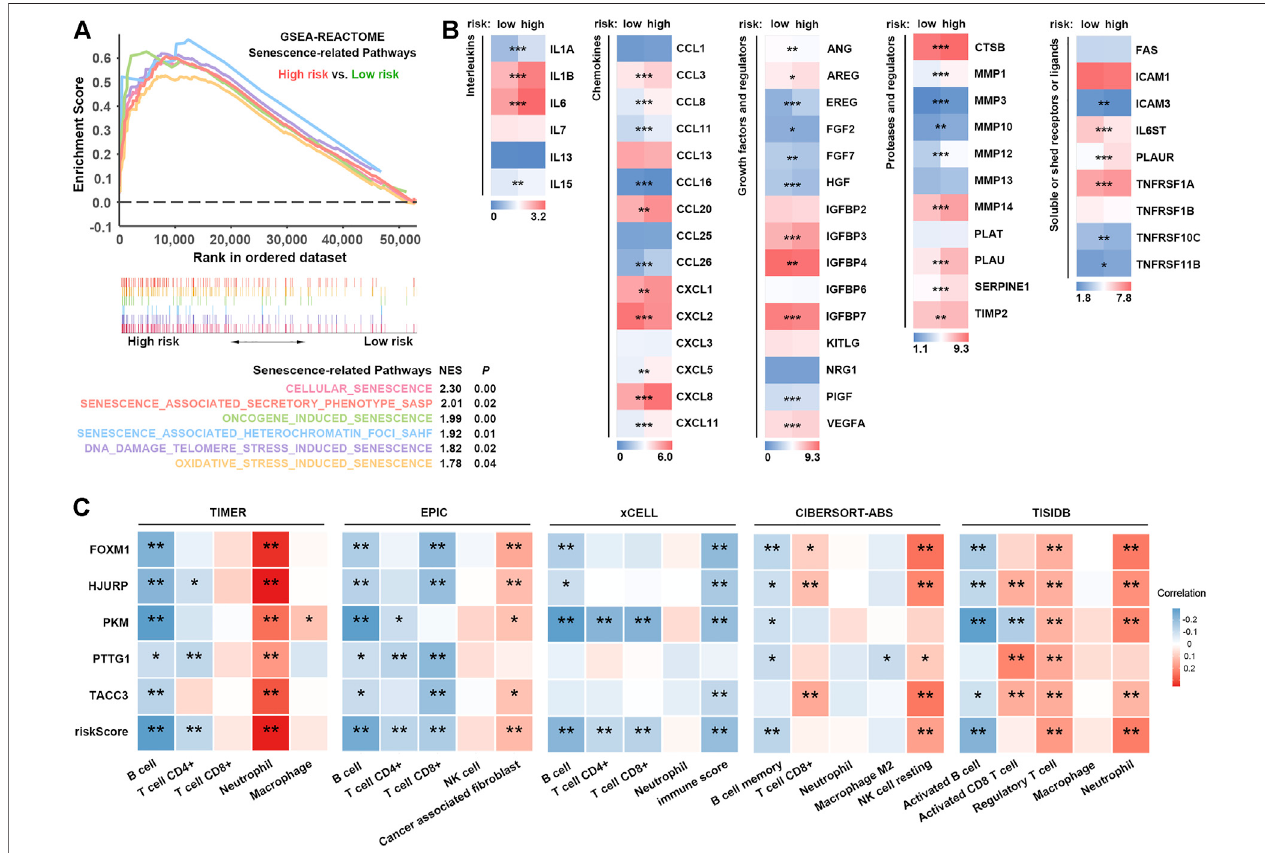
FIGURE 5 | SRS-related SASP and immune cell in fi ltration. (A) . Comparison of signatures related to multiple pathways of cellular senescence between high- and low-risk groups. (B) . Expression of different types of SASP factors between high- and low-risk groups. (C) . Correlation analysis between risk scores and different immune cells estimated by TIMER, EPIC, xCELL, CIBERSORT-ABS and TISIDB. *, **, and *** represent P < 0.05, P < 0.01, and P < 0.001, respectively.